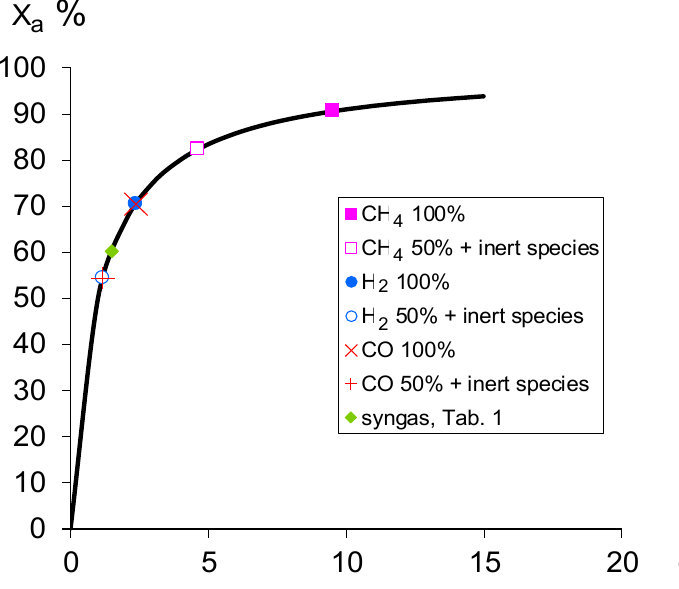
Figure 1. Trend of X a as a function of α vs .